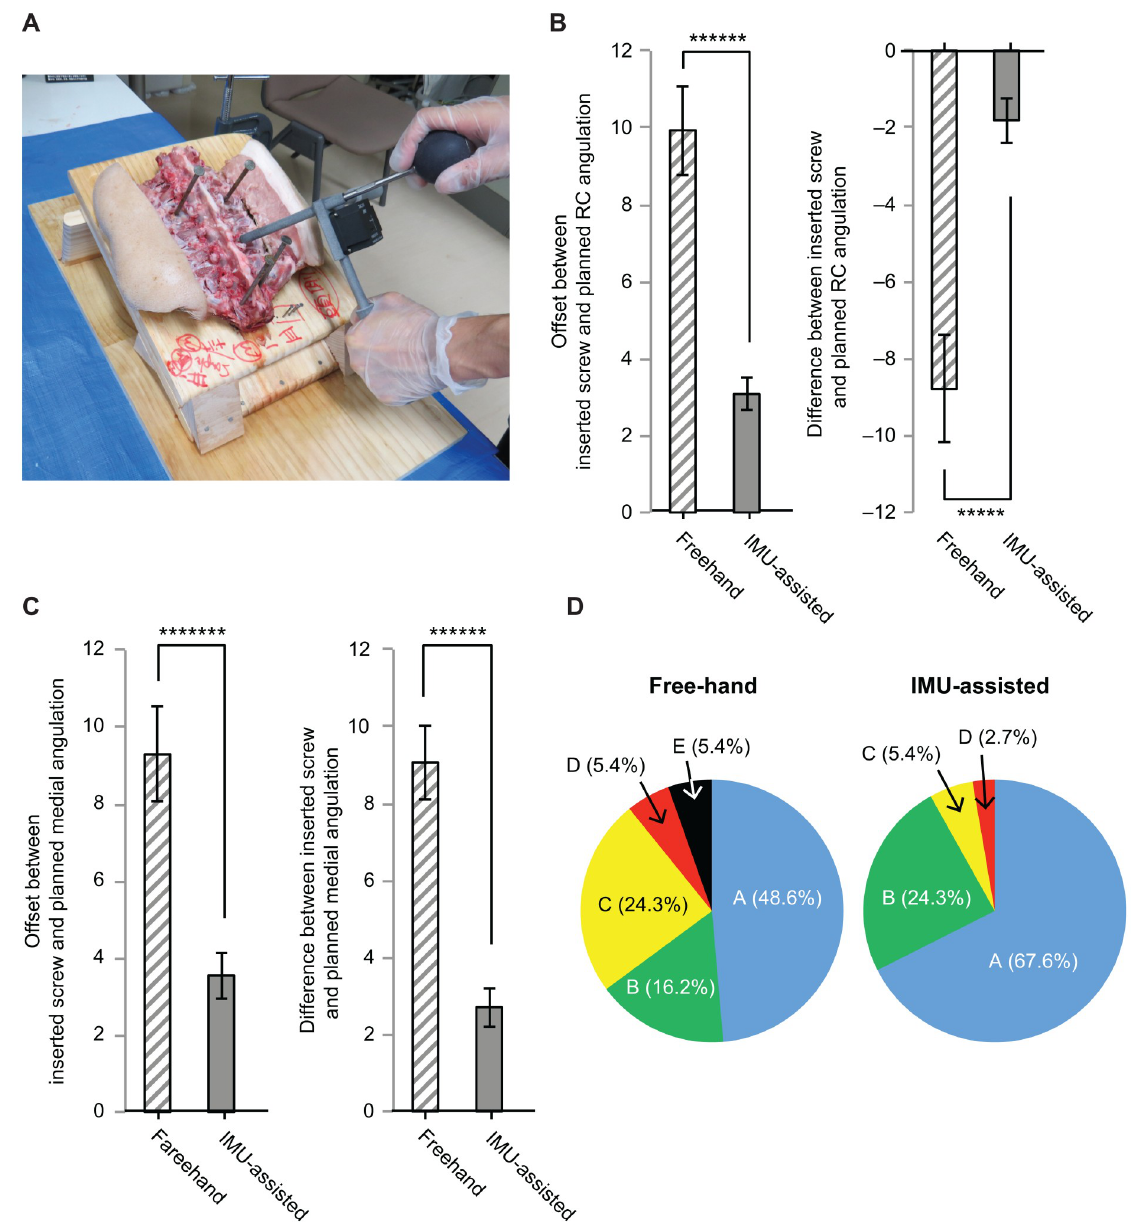
Fig 2. (a), Making a pilot hole for PS placement in the sample on a table tilted 20˚ about the transverse axis by using IMU assist. (b), Left), Mean offsets between the inserted PS and preoperatively planned rostro-caudal rotations about the transverse axis in the head-down-tilted samples. Right), Average difference between the preoperatively planned and inserted PS rostro-caudal rotations about the transverse axis (see Material and methods) in the head-down-tilted samples for the freehand and IMU-assisted groups. ������ : p < 0.000001, ����� : p < 0.00001. (c), Left), Mean offsets between the preoperatively planned and inserted PS medio-lateral rotations about the perpendicular axis in the head-down-tilted samples for the freehand and IMU-assisted groups. Right), Average difference between the preoperatively planned and inserted PS medio-lateral rotations about the perpendicular axis (see Material and methods) in the head-down-tilted samples for the freehand and IMU-assisted groups. ������� : p < 0.0000001, ������ : p < 0.000001. (d), Pie charts demonstrating the proportion of positioning of PS in the head-down-tilted samples in the freehand and IMU-assisted groups classified by the Gertzbein and Robbins classification system.